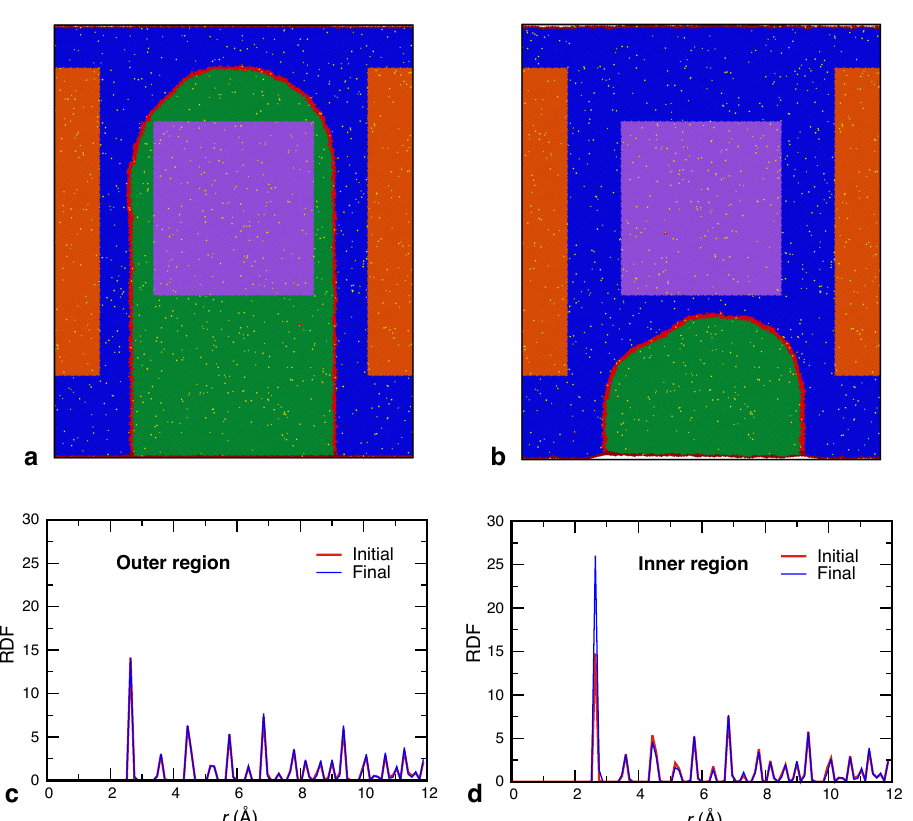
Figure 7. ( a , b ) GB position in the beginning of the MD simulation ( a ) and closer to the end ( b ). Cu atoms of the outer and inner grains are shown in blue and green, respectively. The GB atoms are shown in red and Ag atoms in yellow. The purple rectangular region is selected to show the SRO formation and is swept by the GB motion. The orange region lies completely in the outer grain and is unaffected by the GB motion. The graphs below compare the Ag–Ag RDFs in the two states shown ( a , b ) for the outer ( c ) and inner ( d ) regions, respectively. Note the significant rise in the first peak in the region traversed by the moving boundary.